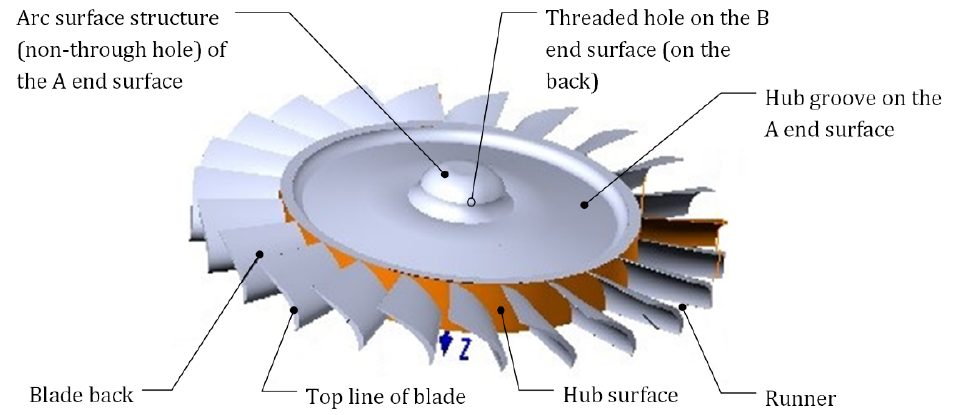
Figure 7. Structure diagram of a micro-turbine.